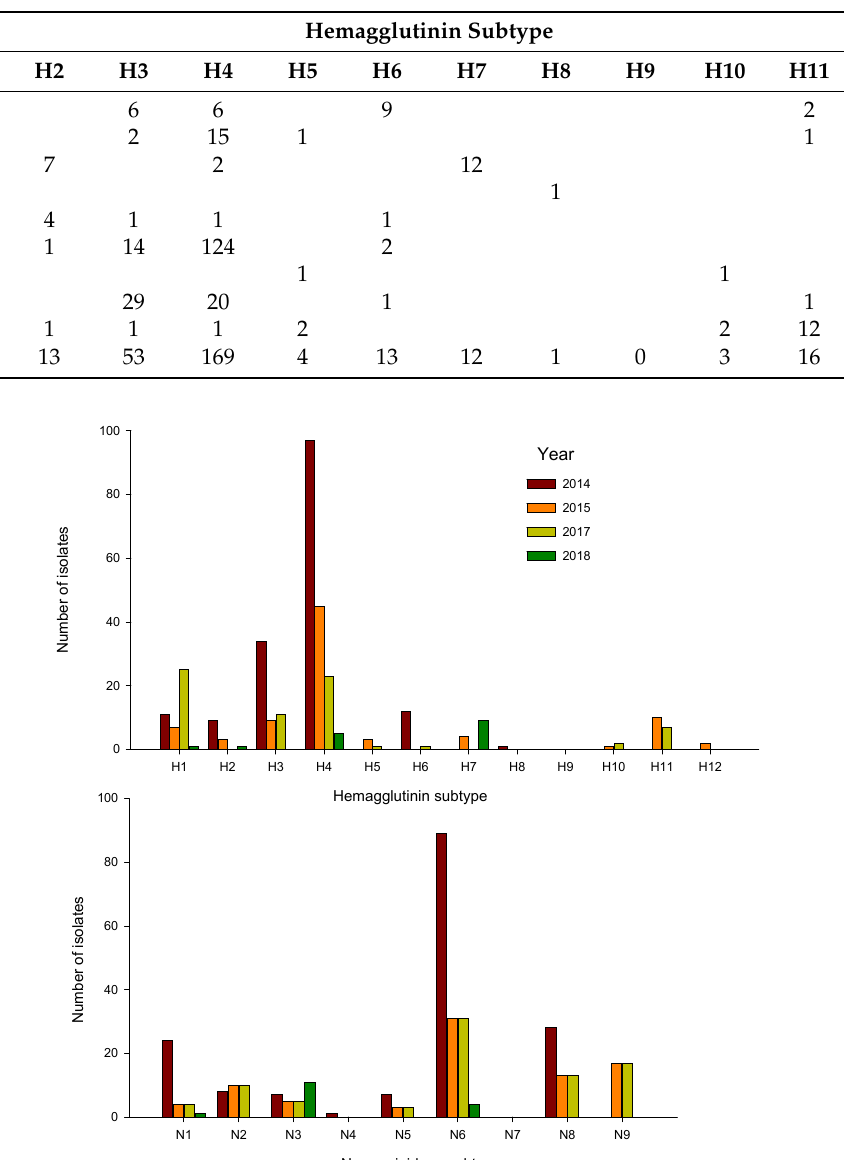
Table 2. Influenza A virus subtype diversity detected in wild mallards sampled in Northwest Minnesota, USA in 2014, 2015, 2017, and 2018, totaled across all years.